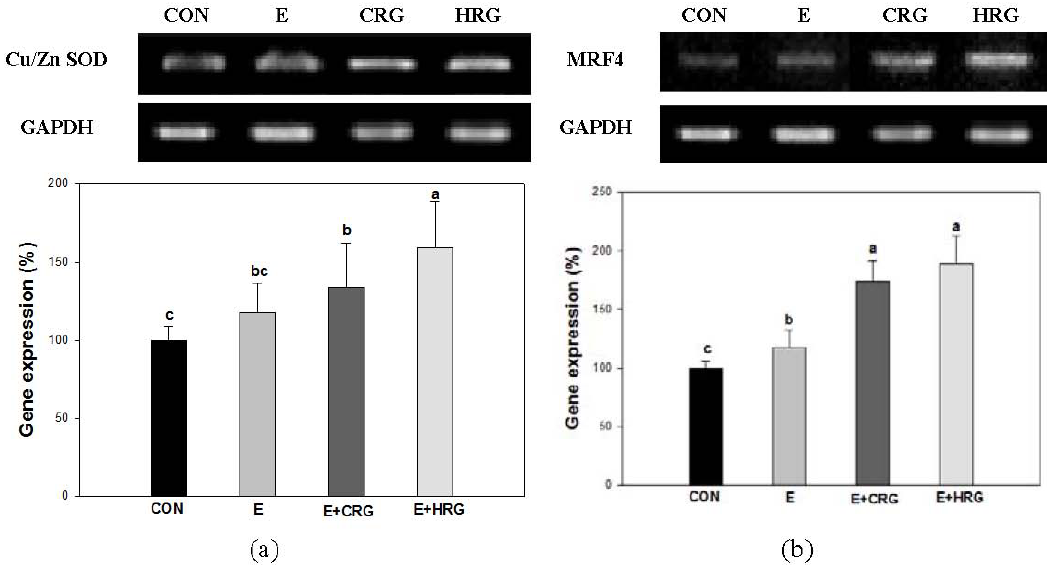
Figure 4. Effects of HRG on Cu/Zn SOD and MRF4 mRNA expression levels in muscle tissue. ( a ) Cu/Zn-SOD, ( b ) MRF4. The results are given as the mean ± standard ( n =